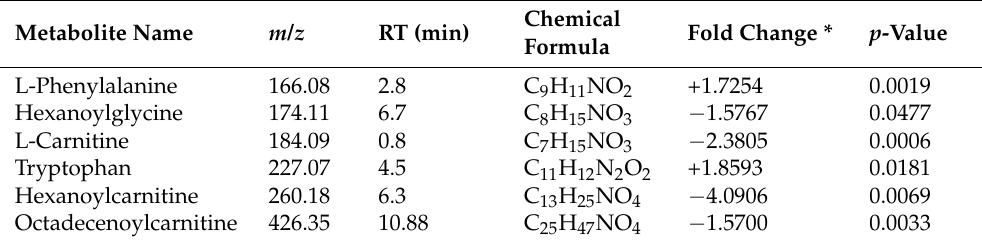
Table 4. Differences in metabolite levels between CDAA and the CSAA